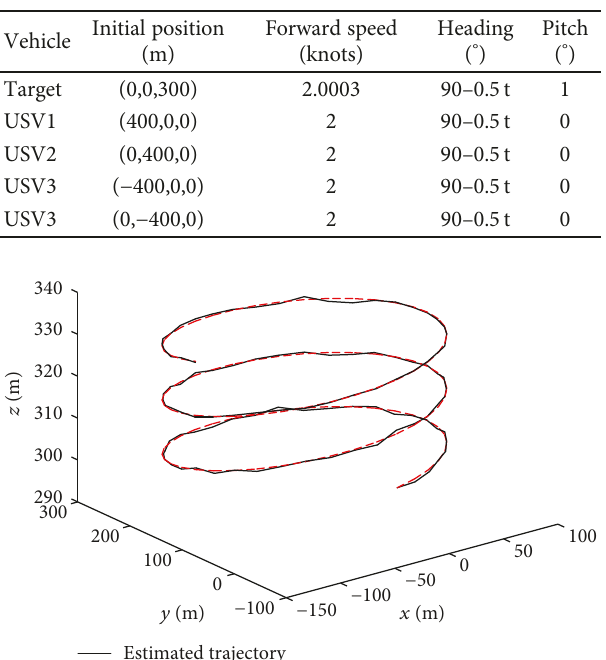
Table 2: Parameters of USVs and target in optimal formation.